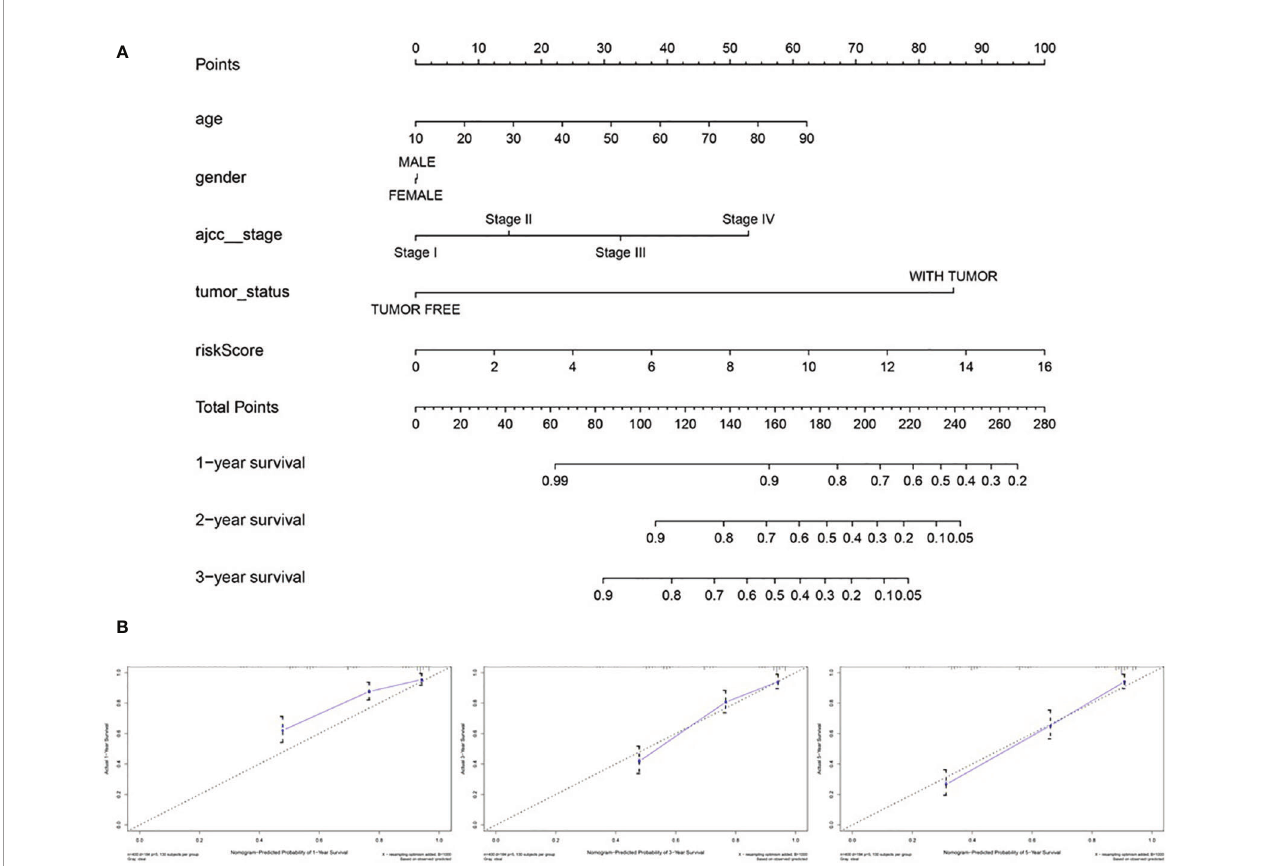
FIGURE 7 | The nomogram of predicting 1-, 3 ‐ , or 5 ‐ year OS and prognostic value of 4 genes in the entire set. (A) The nomogram for predicting 1-, 3 ‐ , or 5 ‐ year OS. (B) The calibration plots for predicting 1-, 3 ‐ or 5 ‐ year OS. Nomogram ‐ predicted probability of survival is plotted on the x ‐ axis; actual survival is plotted on the y ‐